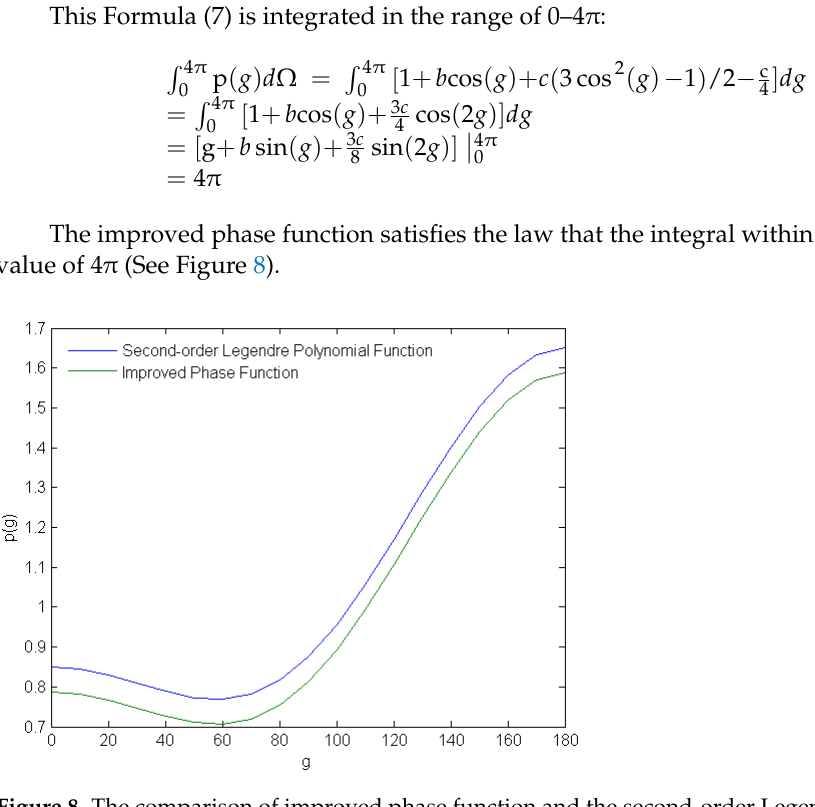
Figure 8. The comparison of improved phase function and the second-order Legendre polynomial function.